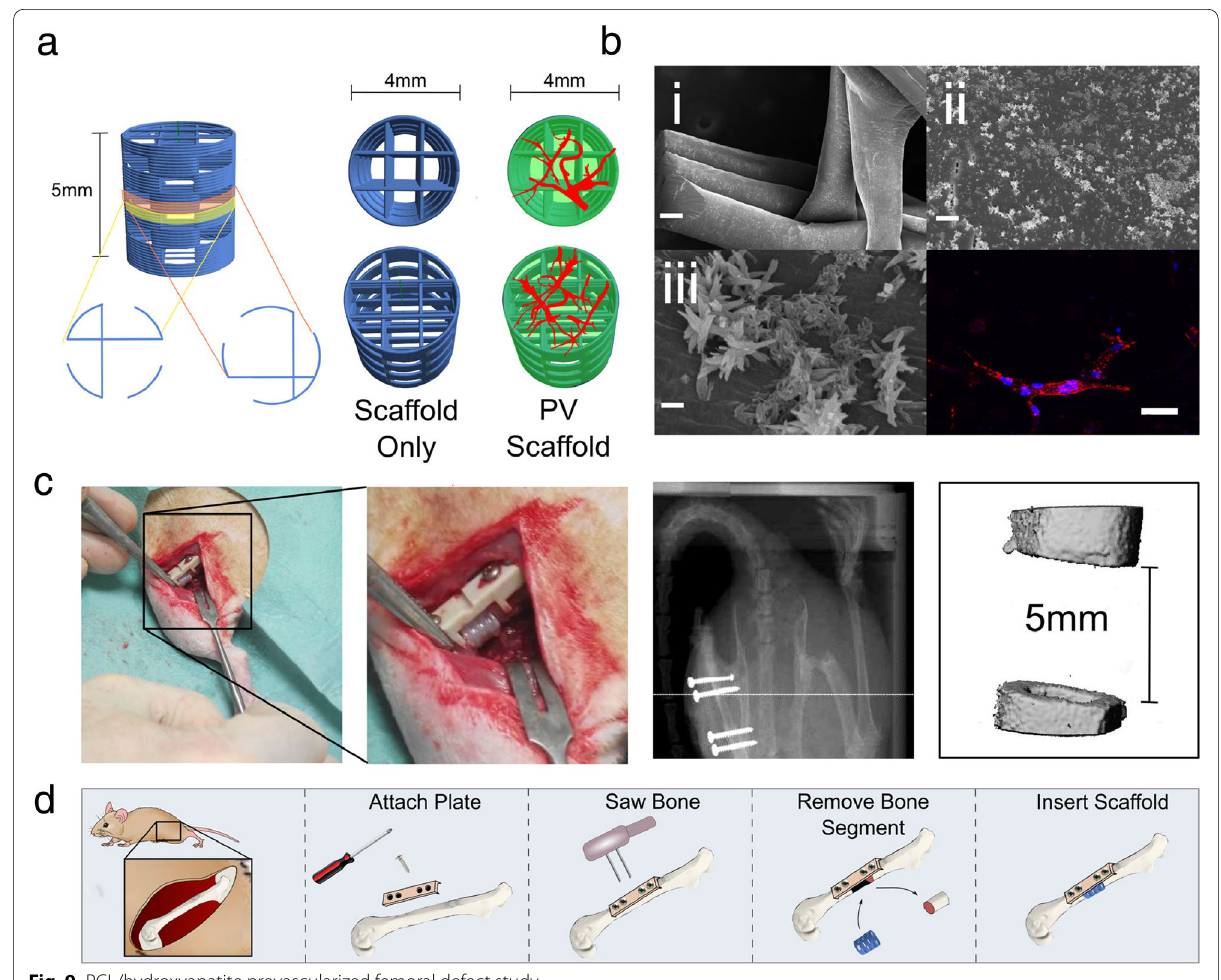
Fig. 9 PCL/hydroxyapatite prevascularized femoral defect study a Porous PCL scaffold design. Two PCL scaffolds were bioprinted; both were 4 mm in diameter and 5 mm high and coated with nano‑hydroxyapatite. One scaffold was left empty whilst the other was filled with prevascularized scaffold bioink. b SEM images depicting nHA coating and confocal image of microvessels within scaffolds. Scale bar in images i, ii, iii and iv 100 μm, 2 μm, 200 nm and 50 μm, respectively. c Images highlighting rat femoral defect location and X‑ray and μCT images showing defect dimensions. d Schematic outlining surgical procedure. Reprinted with permission from